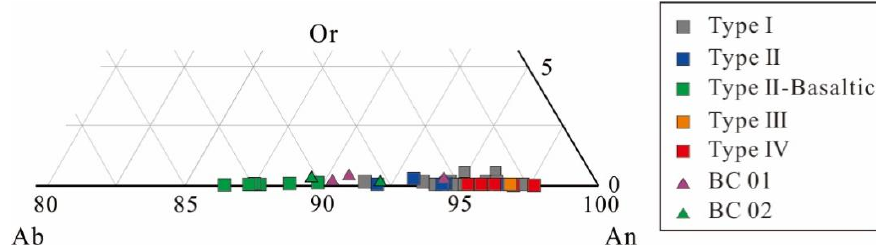
Figure 4. Plagioclase composition in different types of CIM clasts and basaltic clasts.